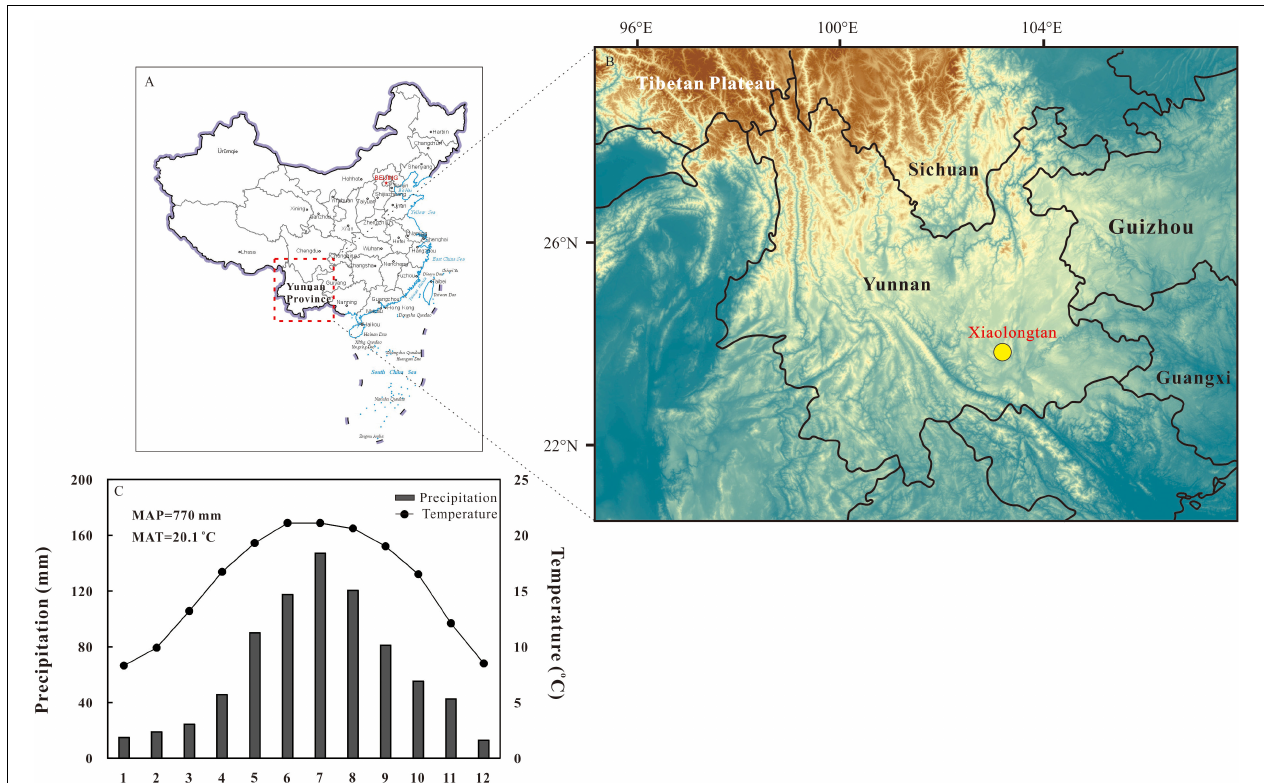
FIGURE 1 | (A) Location of Yunnan Province; (B) location of Xiaolongtan Basin in the Yunnan region at the southeast margin of the Tibetan Plateau; (C) mean monthly temperature and precipitation from Kaiyuan meteorological station from 1981 to